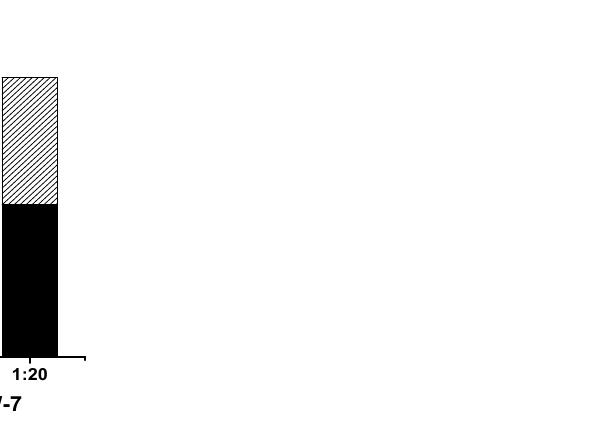
1000 rpm, reaction time 7 h; b [Cat]/[Cell] = 1:20 g·g − 1 . Catalyst loading 0.5 g·L − 1 ; c Cellulose conversion revealed by TOC at a Reaction conditions: initial concentrations of cellulose and catalyst 10 g L − 1 , reaction volume 45 mL, 453 K, P 7 h of the reaction.